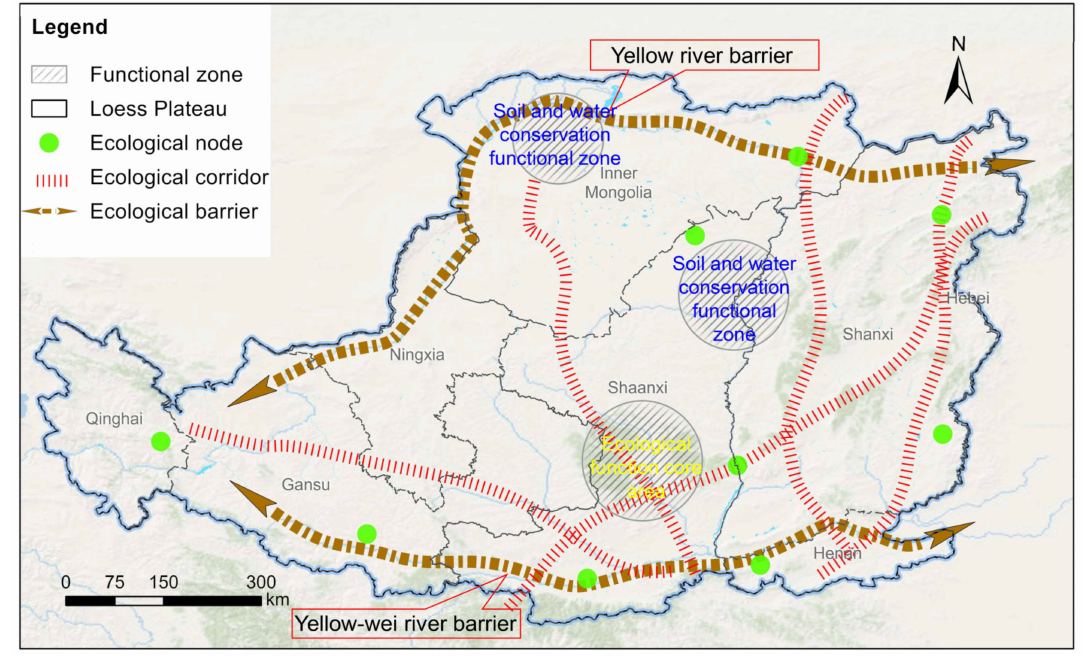
Figure 8. Optimization scheme for ESP of